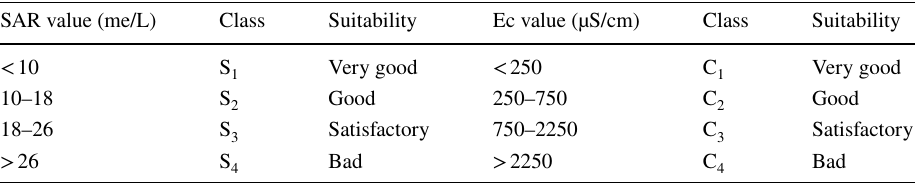
Table 2 Classification of irrigation